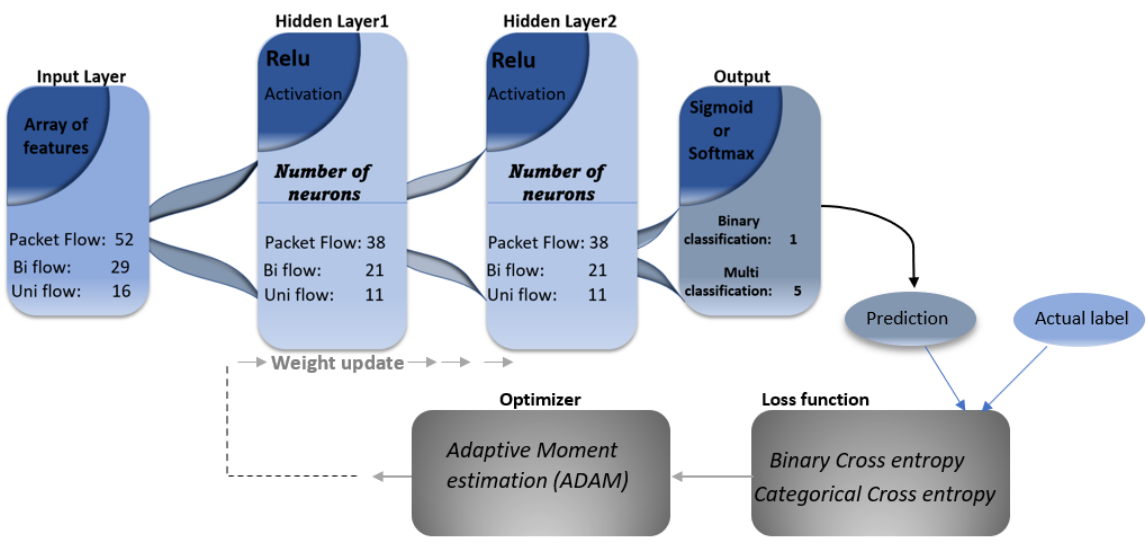
Figure 4. The proposed model’s training setup for binary and multi-attack